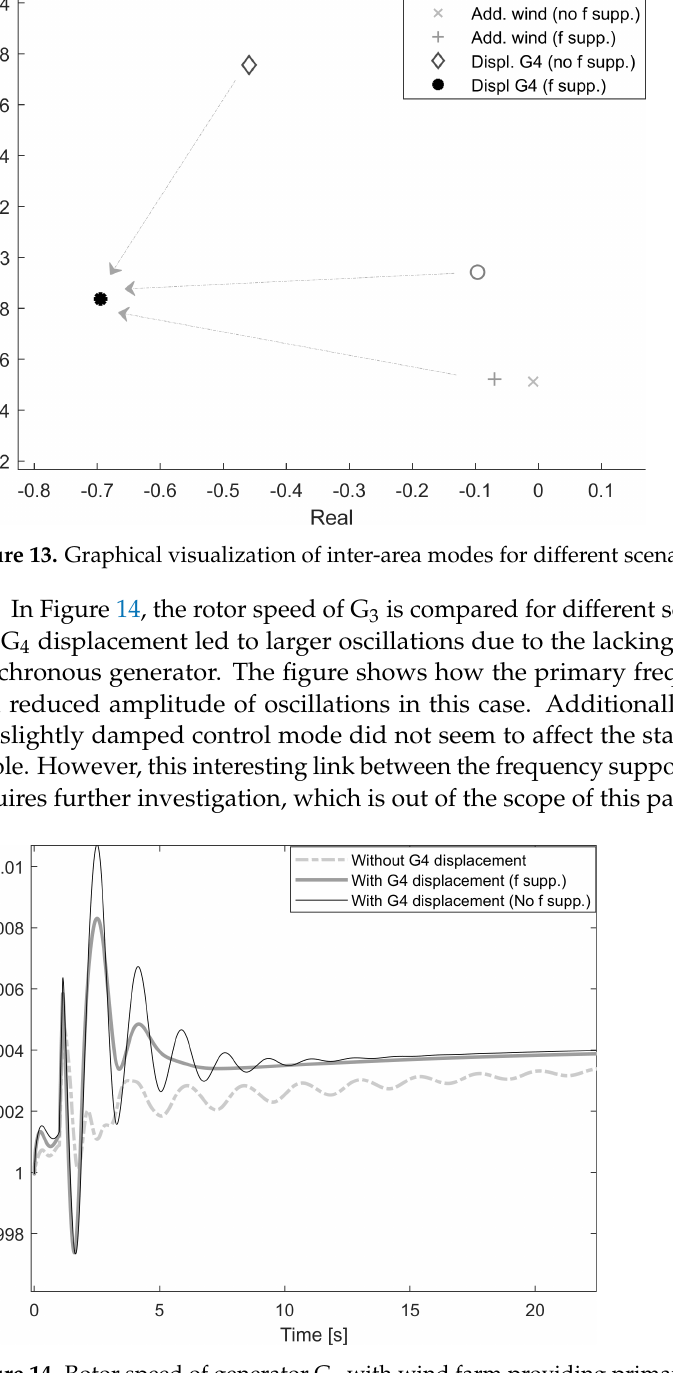
Figure 14. Rotor speed of generator G 3 with wind farm providing primary frequency response with and without displacement of G 4